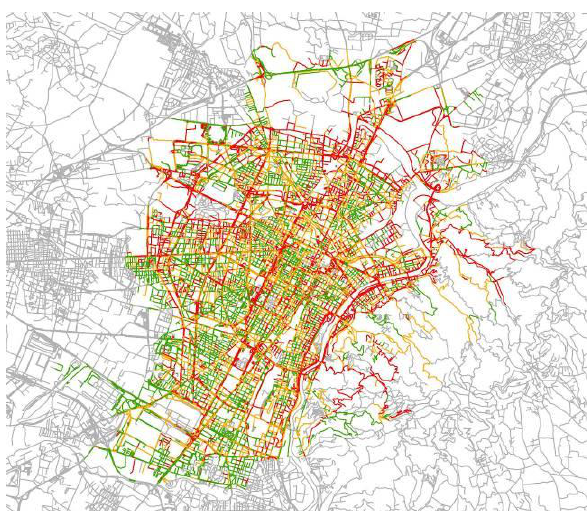
Figure 12. OTM road network classified based on normalised sum of path distances (green=shortest paths, red=longest paths) FCD based system is particularly able to detect jammed situations and the travel times calculated by the system deliver valuable data for mobility and traffic information systems (Brockfeld et al., 2007). Exploiting the recording by FCD of the speed value, it is possible to visualize the mean speed over the whole network: Figure 13 displays the mean speed value considering all records available in the FCD sample and clearly highlight main high speed roads and local roads. The use of the timestamp associated to FCD data allows to calculate mean speeds in the different moments of the day (Figure 14), useful for estimating dynamic travel